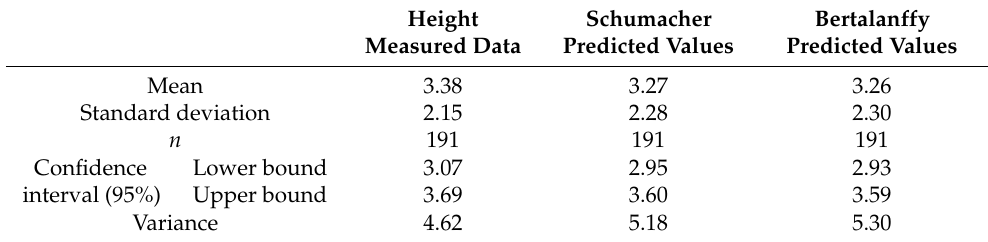
Table 10. Comparison of the descriptive parameters calculated for each of the datasets.